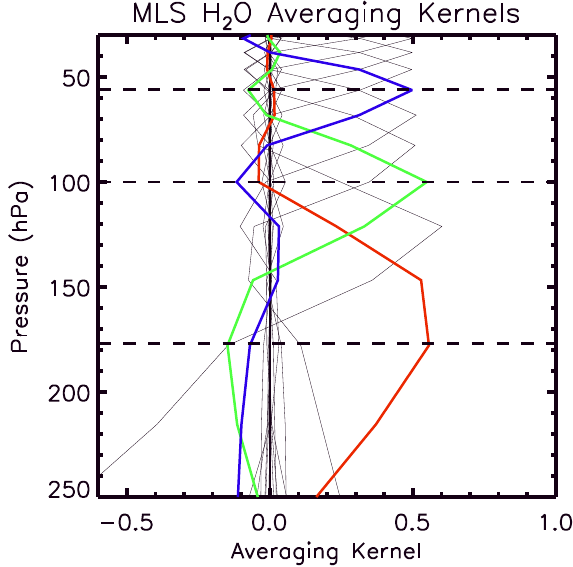
Figure 3. MLS H 2 O averaging kernels from 250 to 30hPa. Dashed lines represent the 177, 100, and 56hPa levels. The red, green and blue lines represent the averaging kernels peaking at 177, 100 and 56hPa,